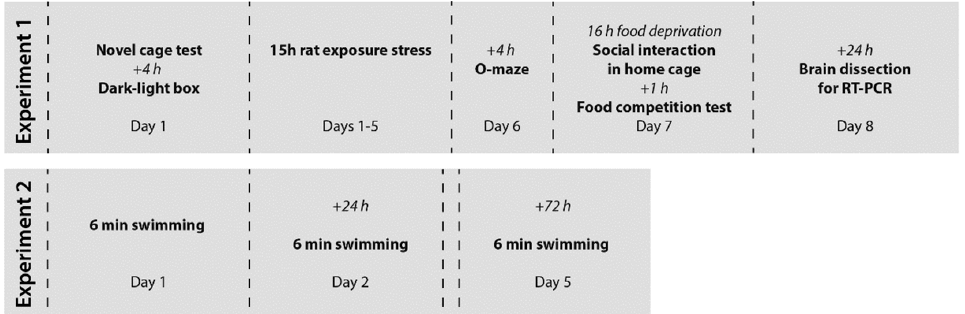
Figure 1. Experiment design. (Experiment 1) Female Tph2 +/ − mice and their wild type